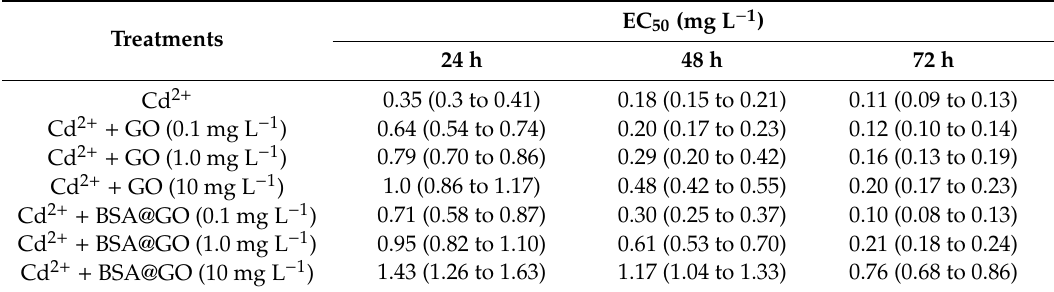
Table 2. The EC 50 values (immobilisation) obtained from exposure to mixtures of Cd 2 + (0.1–2.1 mg L − 1 ) at three concentrations (0.1, 1.0 and 10 mg L − 1 ) of GO and BSA@GO in D. magna after 24, 48 and 72 h. PriProbit software was used to obtain the EC 50 values via Probit analysis including the 95% confidence